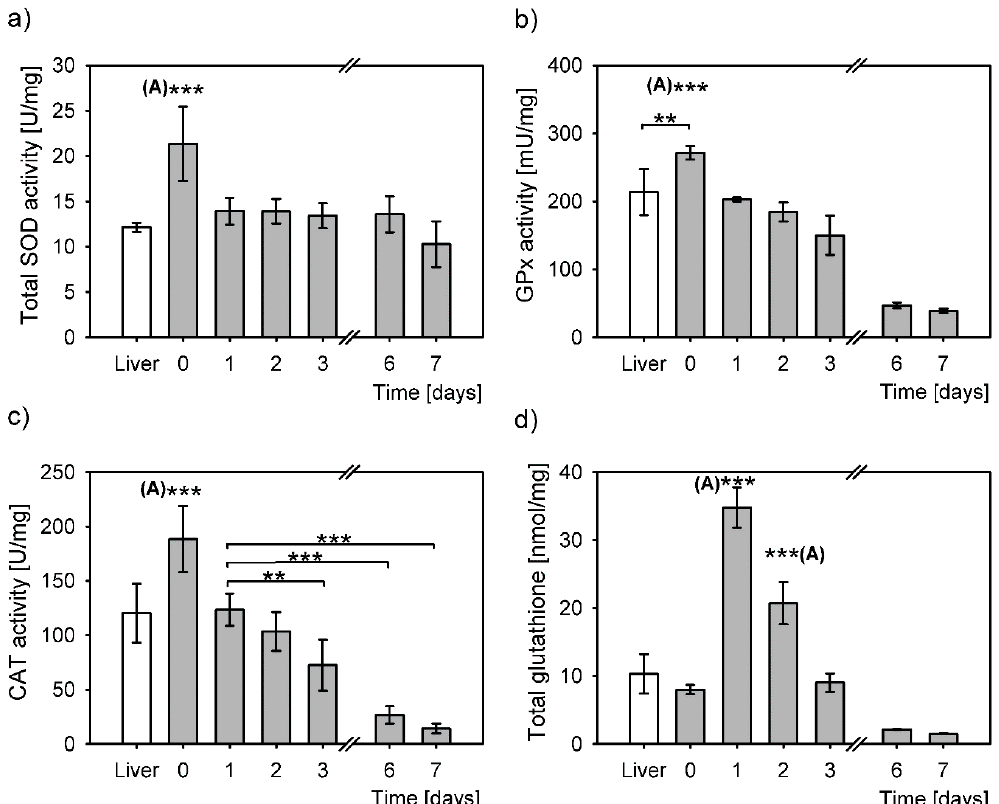
Figure 2. Antioxidative response to oxidative stress in liver (white bars) and in primary hepatocytes at six different time points after cell isolation (grey bars). The values determined in liver and in primary hepatocytes were normalized to mg of total protein and expressed as means ± SD. Statistical significance is represented by “*” symbols (**: P < 0.01, ***: P < 0.001). “(A)”: significantly differs to all other time points/categories. ( a ) Superoxide dismutase activity (SOD). Overall statistically significant difference between the time points (one-way ANOVA, P = 4 × 10 − 6 ), however only SOD activity right after isolation (day 0) differs significantly to all the other time points (to liver: P = 9 × 10 − 5 , day 1: P = 3 × 10 − 4 , day 2: P = 2 × 10 − 4 , day 3: P = 6 × 10 − 5 , day 6: P = 2 × 10 − 4 , day 7: P = 1 × 10 − 6 , Bonferroni post hoc test). ( b ) Glutathione peroxidase activity (GPx). Overall statistically significant di ff erence between the time points (one-way ANOVA, P = 3 10 − 13 ). Bonferroni post hoc test: significant di ff erences between ×